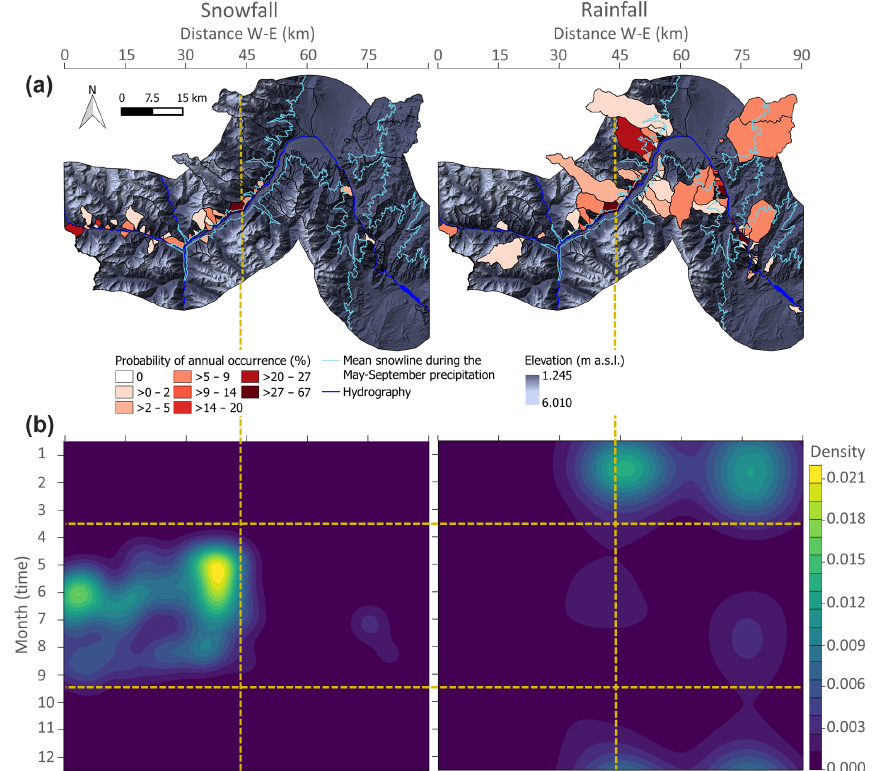
Figure 5. Distributions of the two triggers of G-CHs. (a) Probability of G-CH annual occurrence for each ravine, talus cone and rock wall monitored, superimposed on a topographic map. (b) Monthly mean probability density along a west–east transect for snowfall (left) and rainfall (right). The horizontal axis indicates the distance eastward from the Andes ridge. The cyan lines indicate the mean winter freezing level. Horizontal lines indicate the seasonal division and vertical line the longitudinal division.